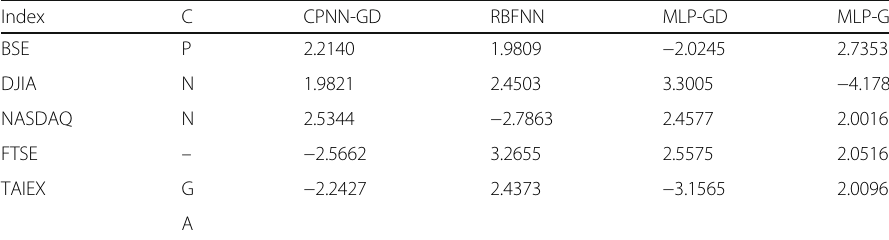
Table 5 Computed DM statistic values from all models and stock indices